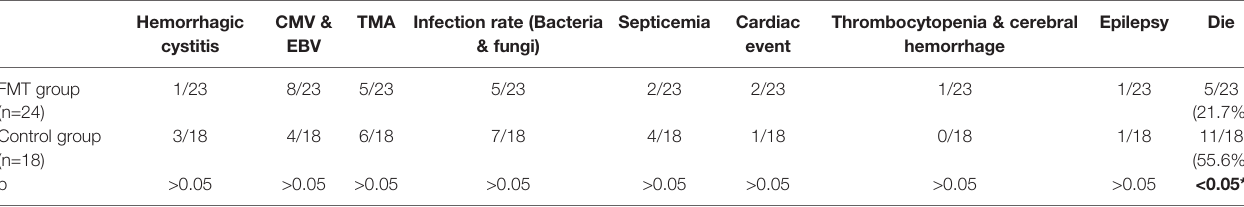
TABLE 3 | Adverse events during overall follow-up